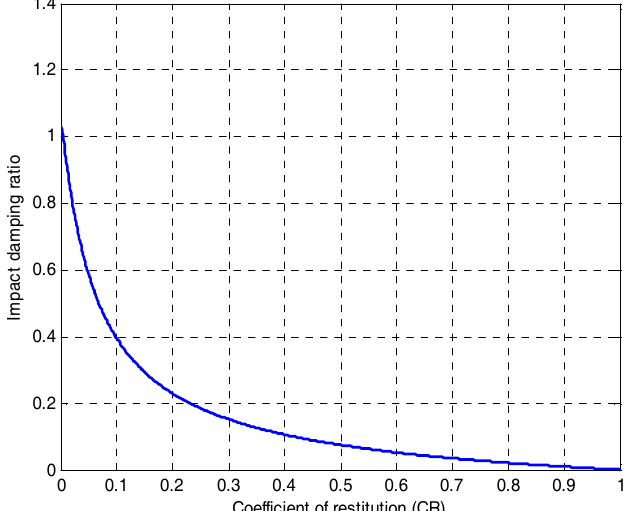
Figure 2. Relation between impact damping ratio and coefficient of restitution (CR) according to Equation (13).